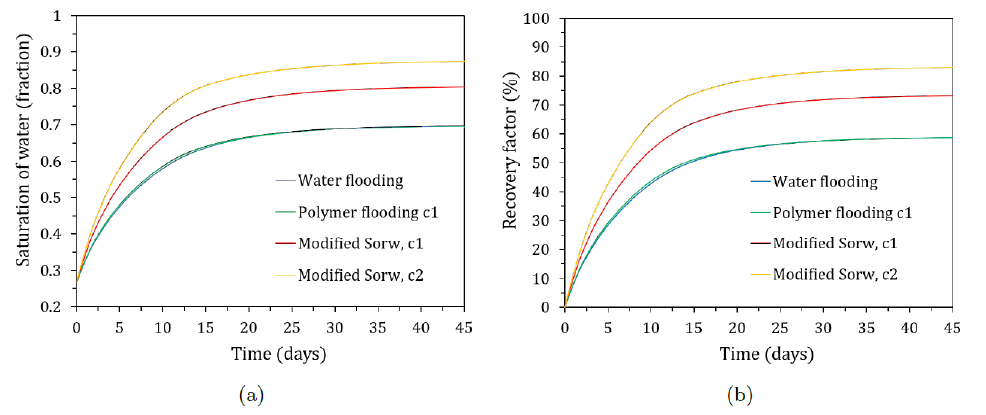
Figure 24. Saturation ( a ) and corresponding recovery factor ( b ) for waterflooding, polymer flooding and modified polymer flooding for two different polymer